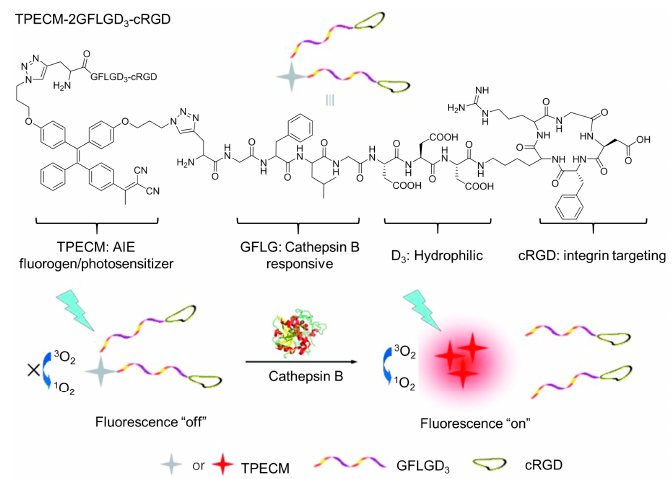
Figure 9. Activatable photosensitizer strategy to manipulate ROS by cathepsin B and pH. Structure of the functionalize TPE derivative TPECM and the bioprobe TPECM-2GFLGD3-cRGD, and the schematic illustration of probe activation by cathepsin B. Reprinted with the permission of the authors of [63]. Copyright 2015, Wiley-VCH GmbH.